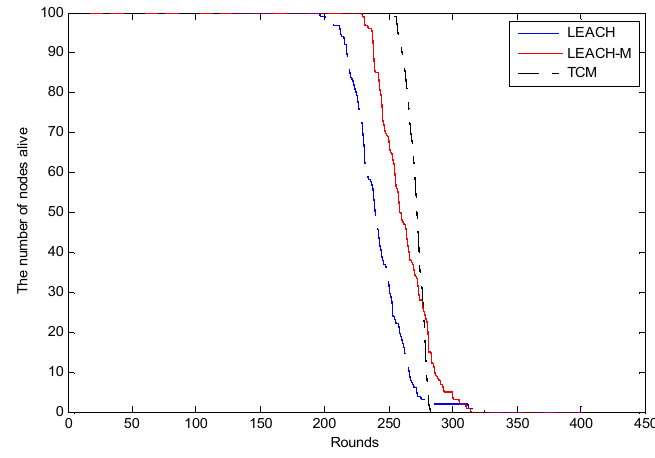
Figure 10. Comparison of the nodes’ survival numbers for three schemes.